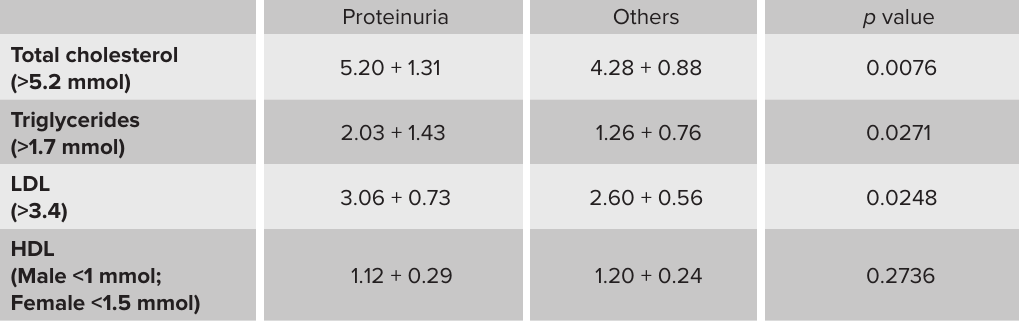
Table 4: The Relationship of Dyslipidemia and